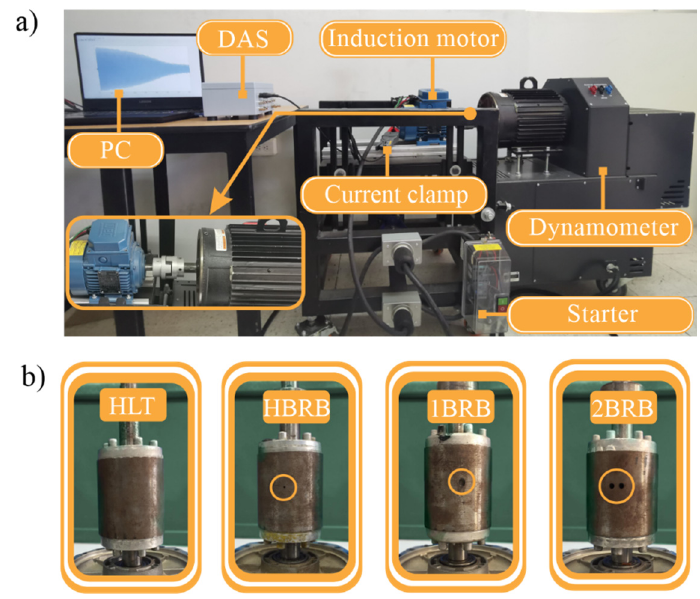
Figure 7. ( a ) Experimental setup; and ( b ) rotor conditions.